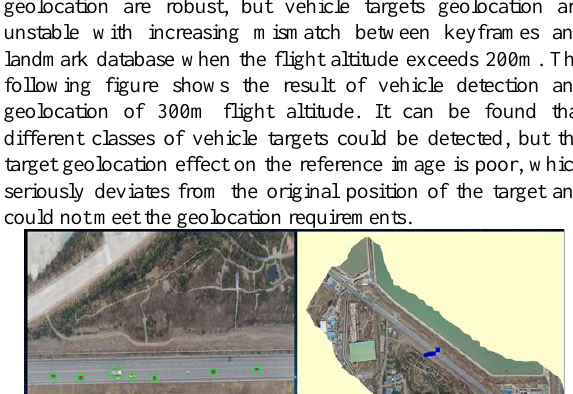
Figure 9. flight altitude 300m vehicle detection and